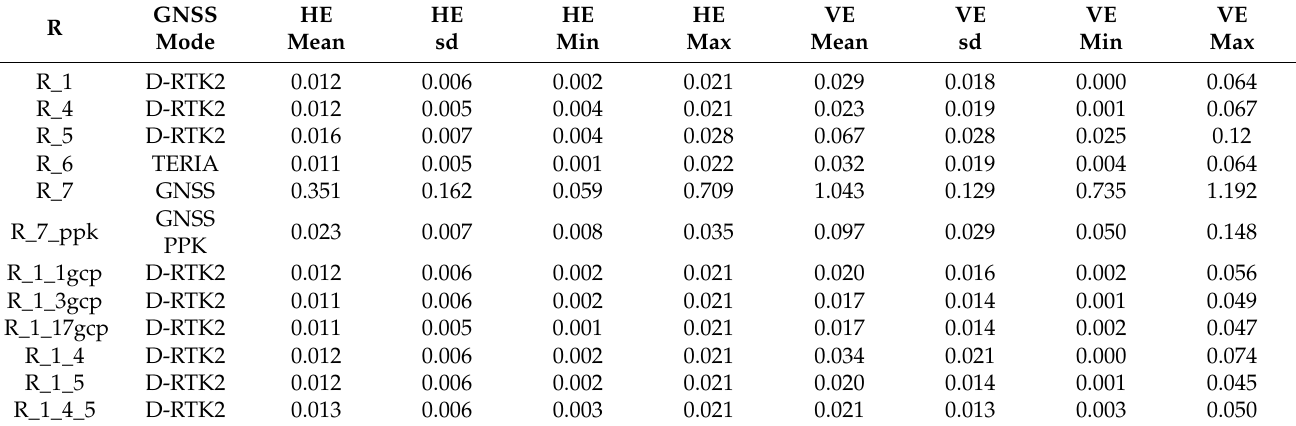
Table 8. Horizontal (HE) and vertical error (VE) statistics for GCP positions for the 12 reconstructions.